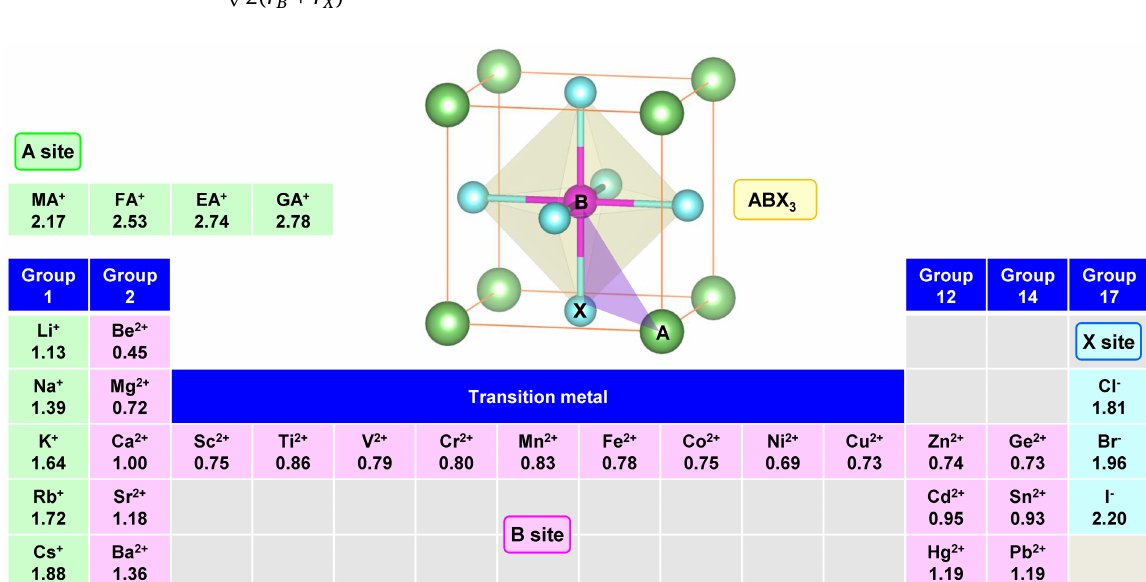
Figure 4: Structural model of ABX 3 perovskite and ionic radii (Å) of elements and